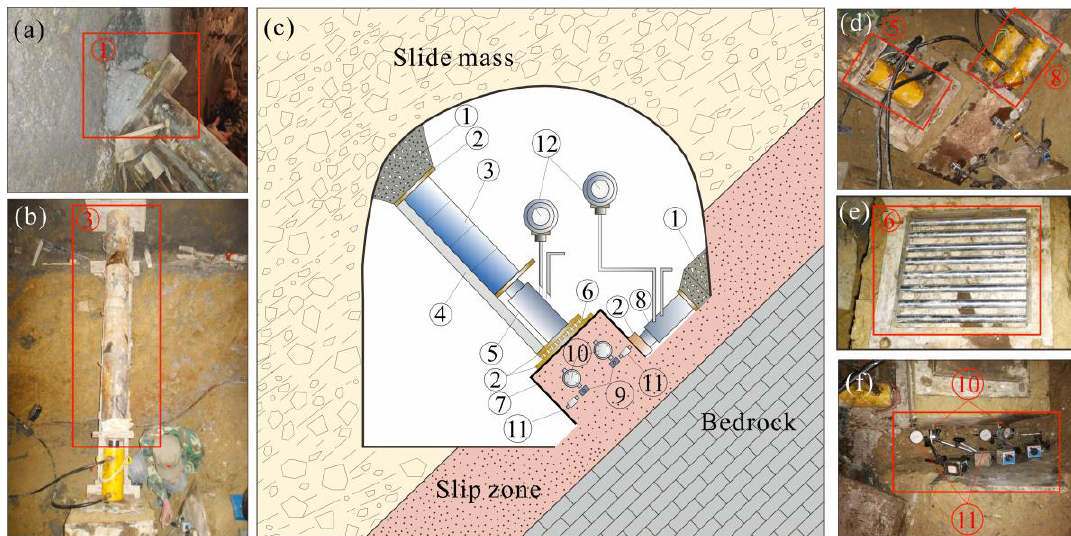
Figure 3. The composition of the in situ shear test apparatus. ① Reaction wall (as shown in ( a )); ② steel backing plate; ③ transfer column (as shown in ( b )); ④ guiding part; ⑤ the normal hydraulic jack (as shown in ( d )); ⑥ steel rollers (as shown in ( e )); ⑦ shear box; ⑧ tangentially arranged hydraulic jacks; ⑨ steel stick; ⑩ normal displacement gauge (as shown in ( f )); ⑪ horizontal displacement gauge (as shown in ( f )); ⑫ pressure gauge.